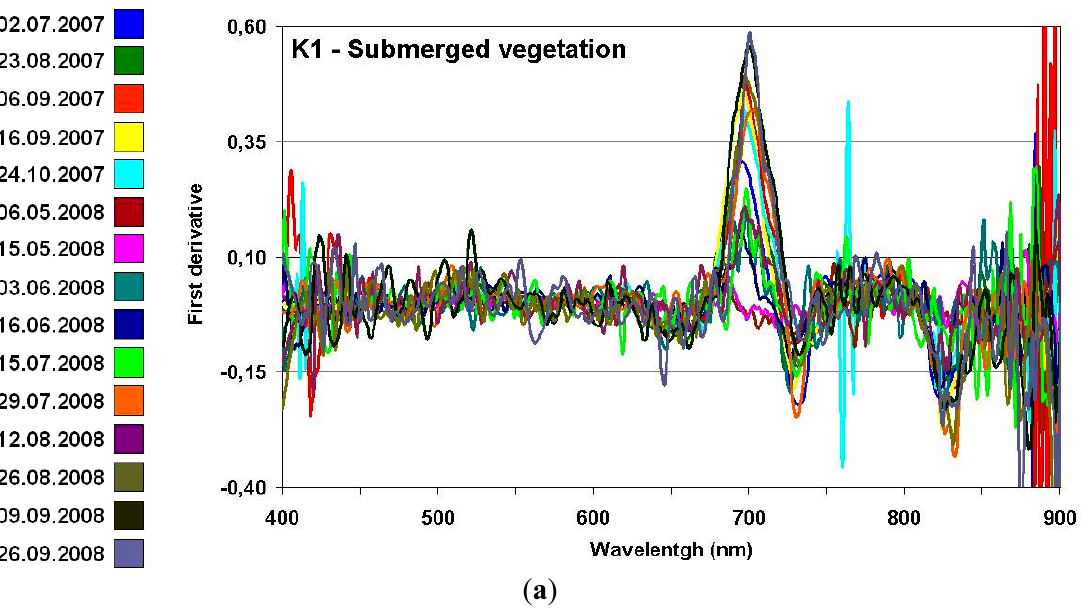
Figure 4. First derivative spectra of kettle holes K1, K4 and K5 calculated from volume reflectance from 2007 and 2008